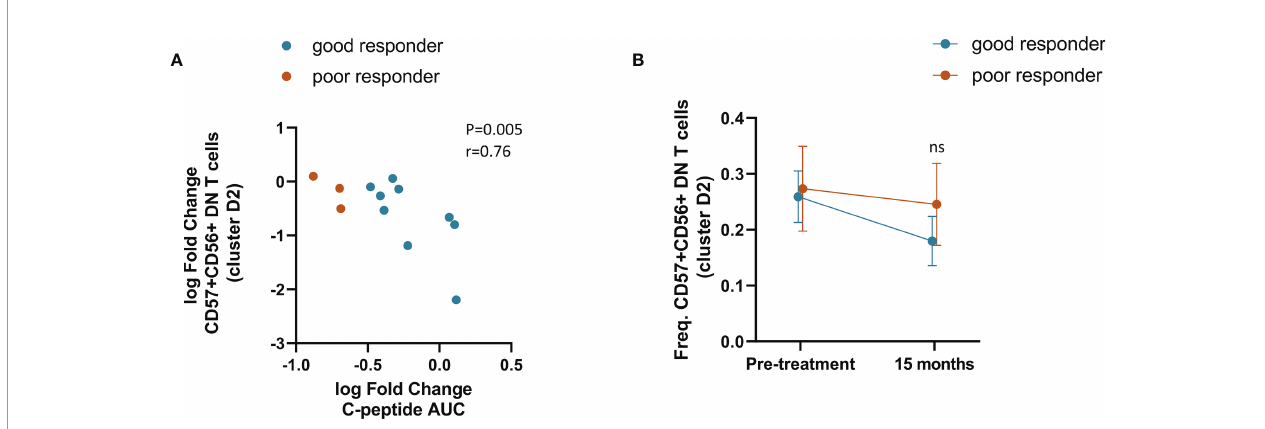
FIGURE 7 | Association between double negative NKT cells with C-peptide preservation after 15 months. (A) Correlation between the change in the frequency of CD57+CD56+ DN T cells and the change in C-peptide from before treatment to 15 months. Spearman correlation was performed. (B) Frequency over time of CD57+CD56+ DN T cells in good responders (n=9) and poor responders (n=3). Mann-Whitney test was performed to compare the difference between the groups. ns, no signi fi